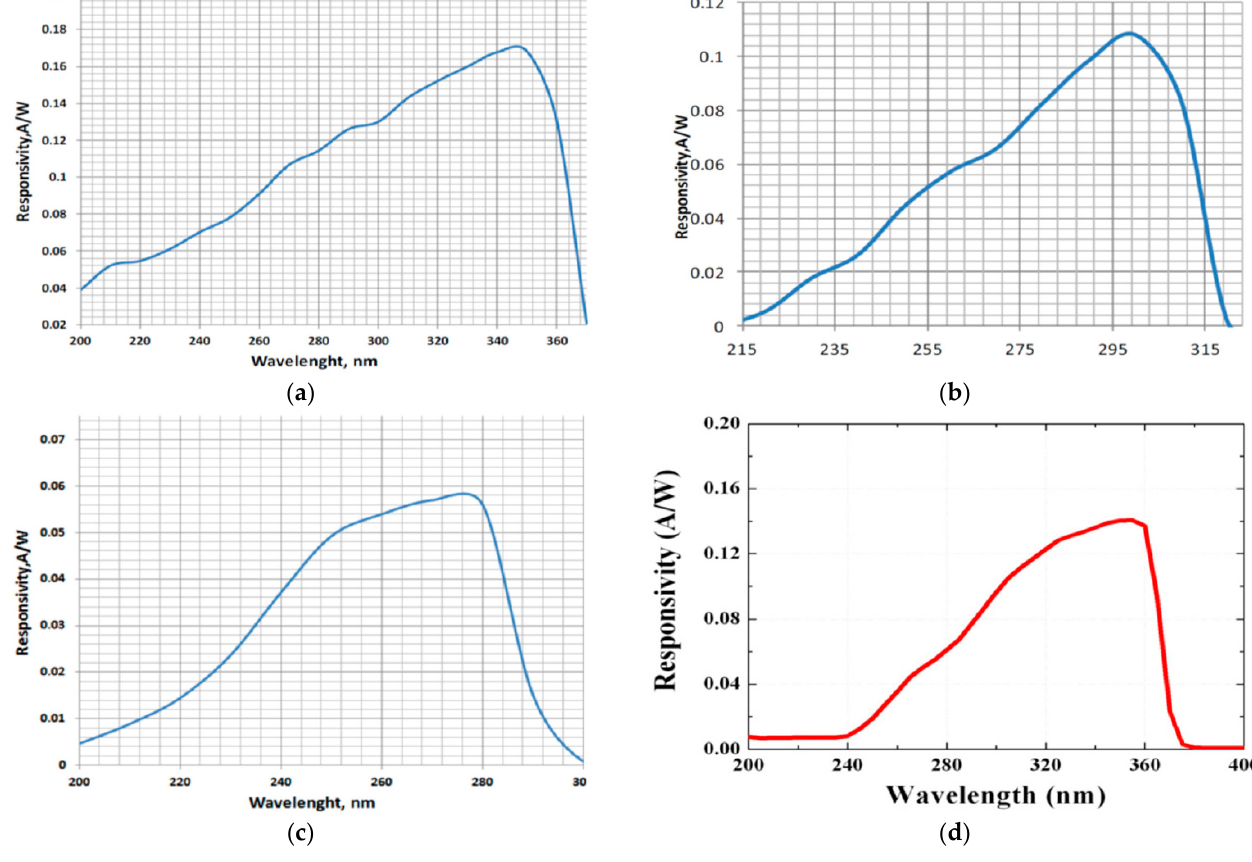
Figure 2. Spectral response of the photodetectors: ( a ) D1 (SD008-2151-112), ( b ) D2 (SD008-2161-112), ( c ) D3 (SD008-2171-112), ( d ) IC1 (GUVA-S12SD). (All the graphs were extracted from the manufac- turer’s datasheet).